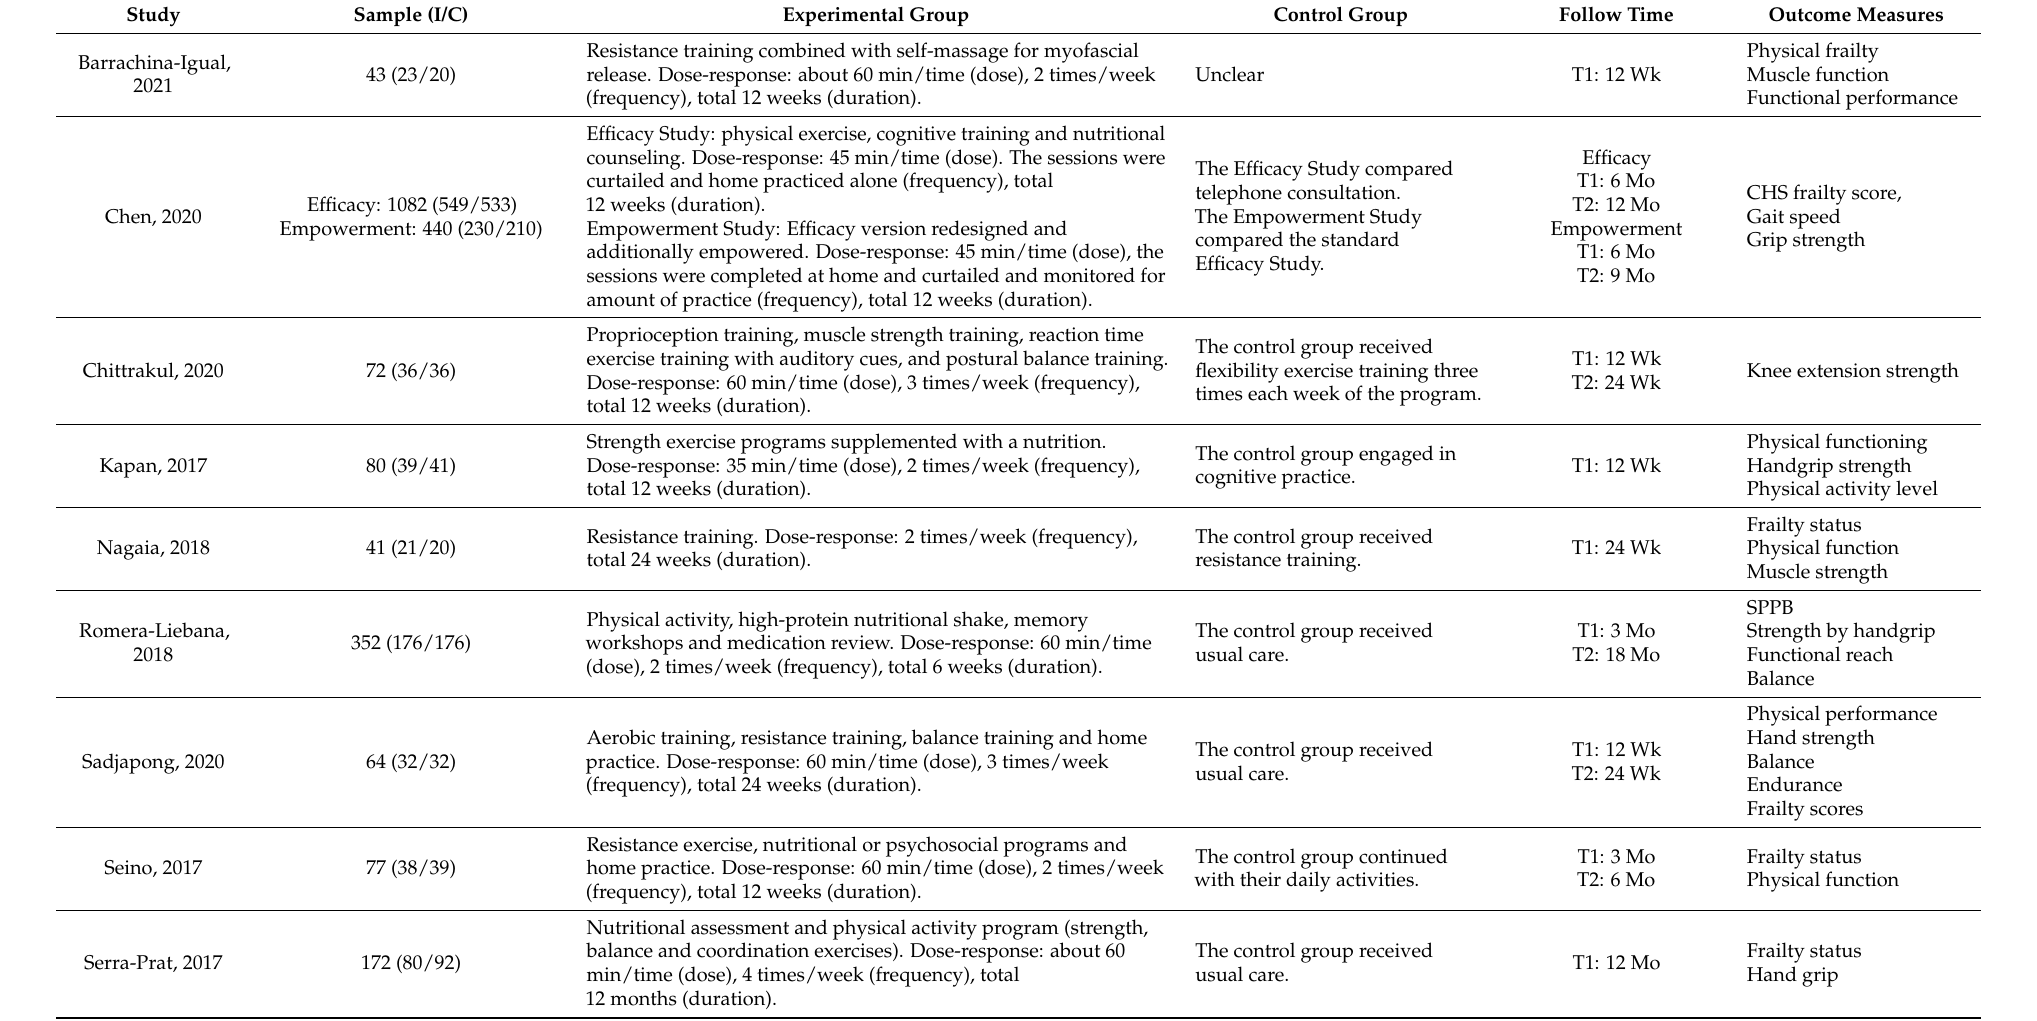
Table 1. Characteristics of the included